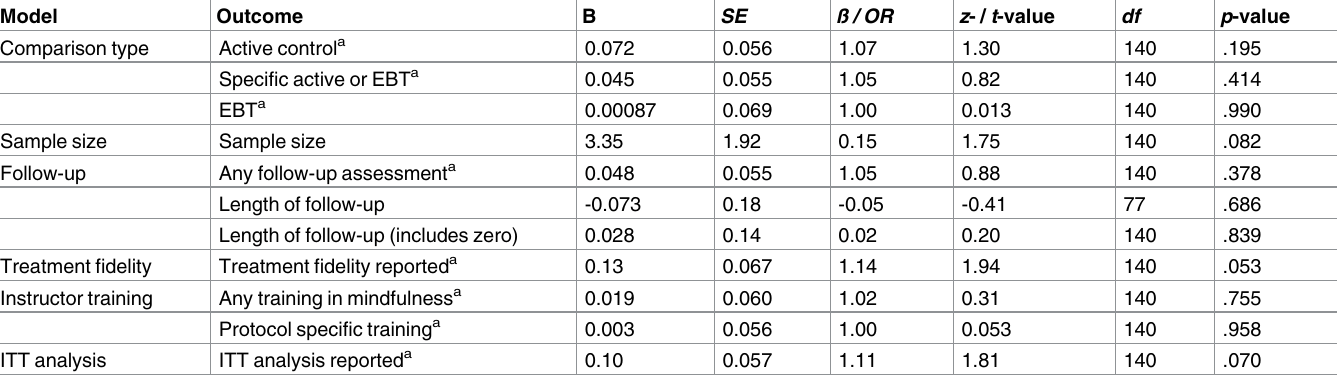
Table 2. Study quality predicted by year of publication (full